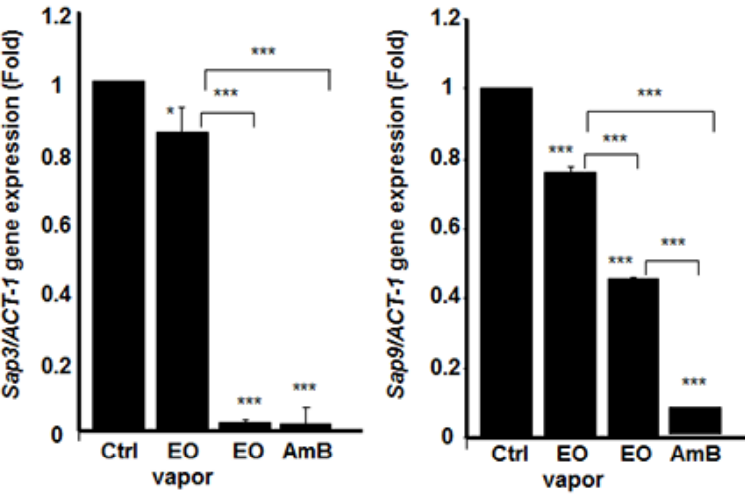
Figure 7. Mentha × piperita essential oil decreased SAP3 and SAP9 gene expression. Following C. albicans culture in the presence or absence of 10 µ L/mL of EO or its vapor, or AmB (1 µ g/mL) for 6 h at 30 ◦ C, total RNA was extracted from each cell culture and qRT-PCR was performed using specific primers for SAP3 or SAP9 . ACT-1 was used as the housekeeping gene for internal control. The plotted values refer to the ratio gene of interest /ACT-1. The changes in mRNA levels are presented as the fold expression of the gene in the test sample compared with this gene’s expression in the control (without EO). Results are expressed as the means ± SD, n = 4. *** p < 0.001. The free asterisks refer to the statistical difference when comparing EO effects to control. The bars with asterisks showed the comparison of EO vapor to the EO liquid, and EO to the AmB.